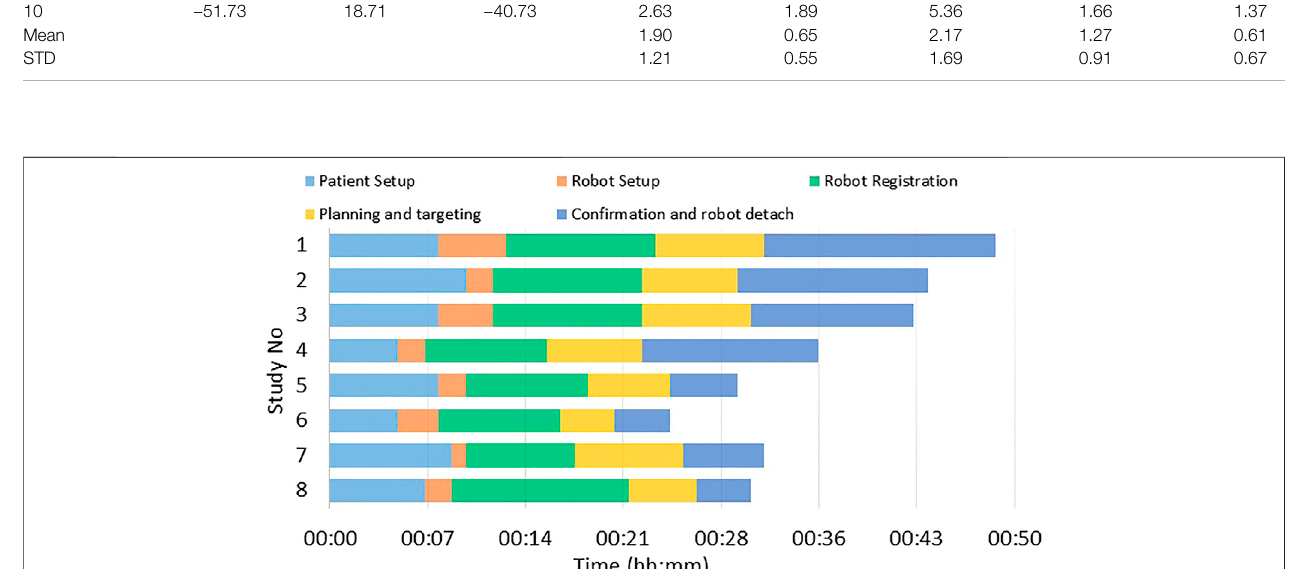
Frontiers in Robotics and AI |